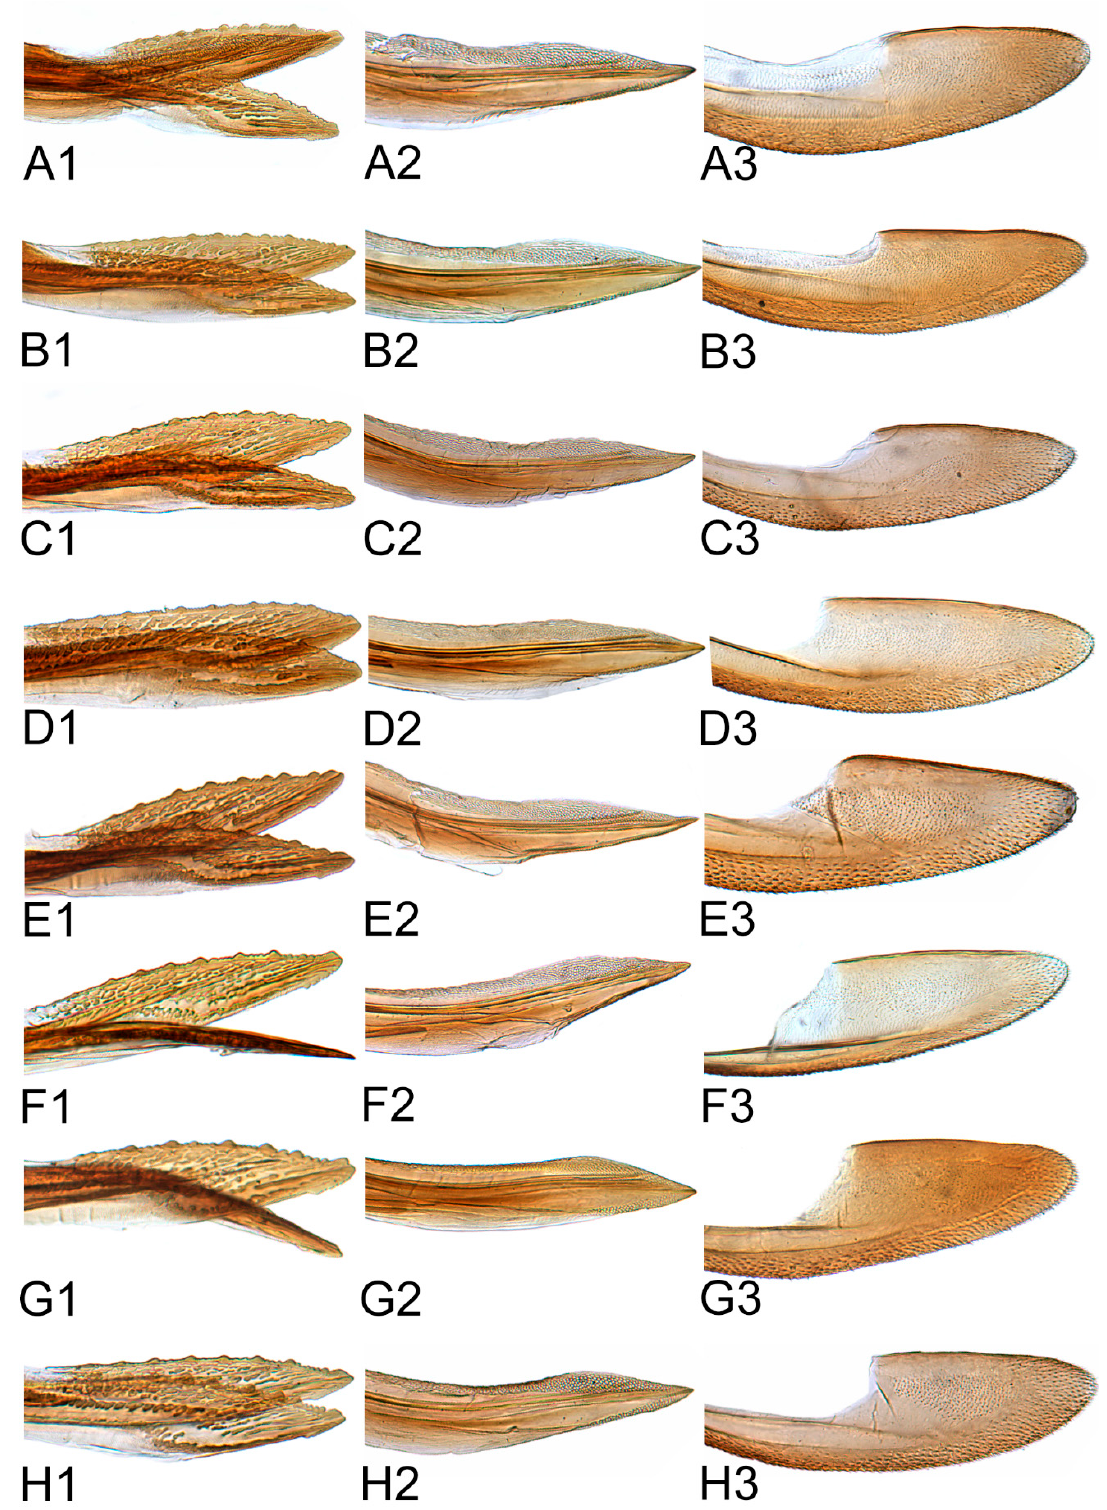
Figure24. Dissectedpartsofovipositor, showingdetailofsecond, first, andthirdvalvulaeapex. ( A1 – A3 Figure 24. Dissected parts of ovipositor, showing detail of second, first, and third valvulae apex. (A1–